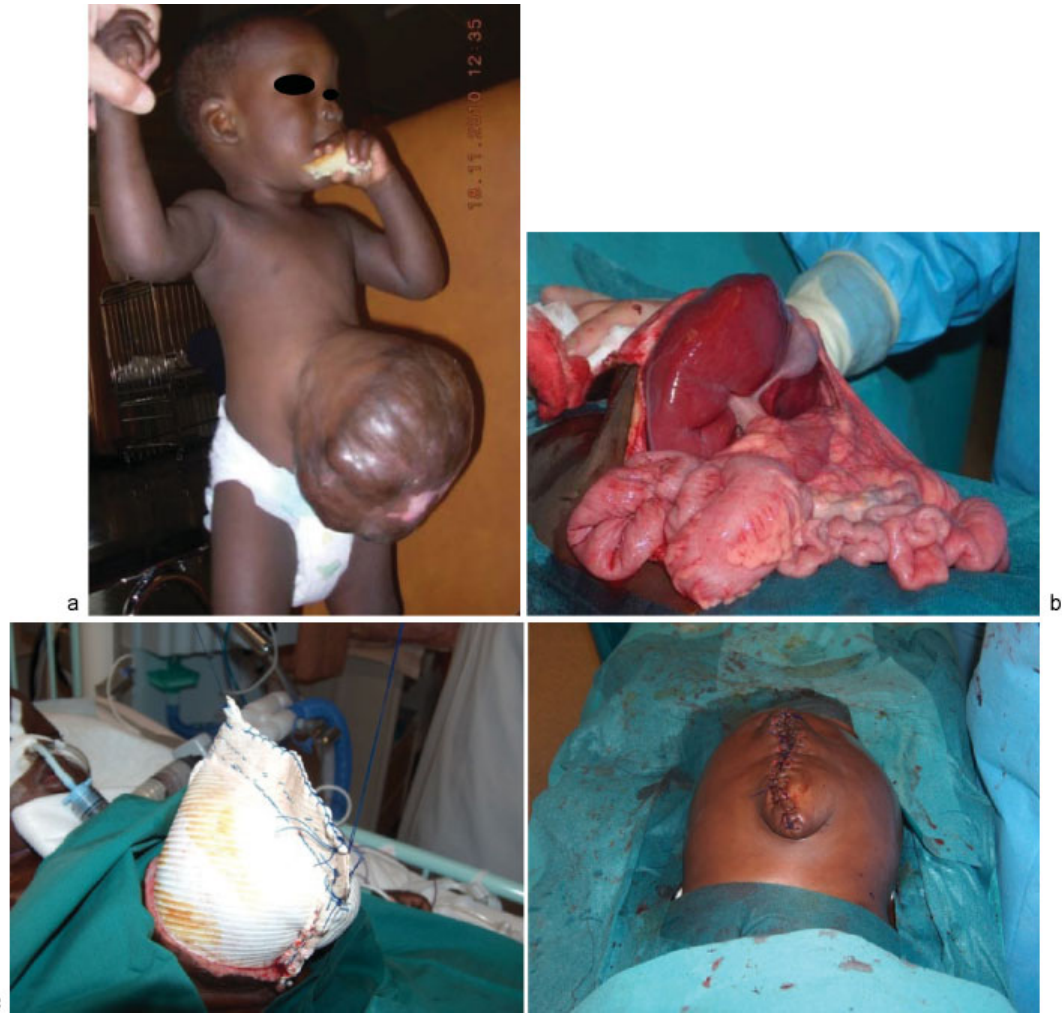
Fig. 1 Steps of ventral hernia correction in patient 5. (A) Preoperative aspects of giant omphalocele (GO). (B) Peroperative aspect: GO content and GO closure using the Schuster technique. (C) Gradual plication and fi nal closure of ventral